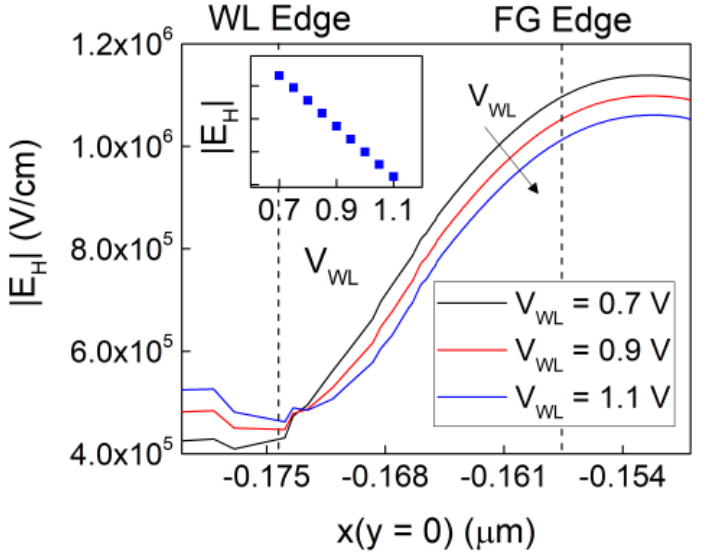
Figure 5. TCAD simulations of the horizontal component of the electric field plotted against the x coordinate in y = 0, between the WL and the FG edges, with the WL voltage as a parameter.